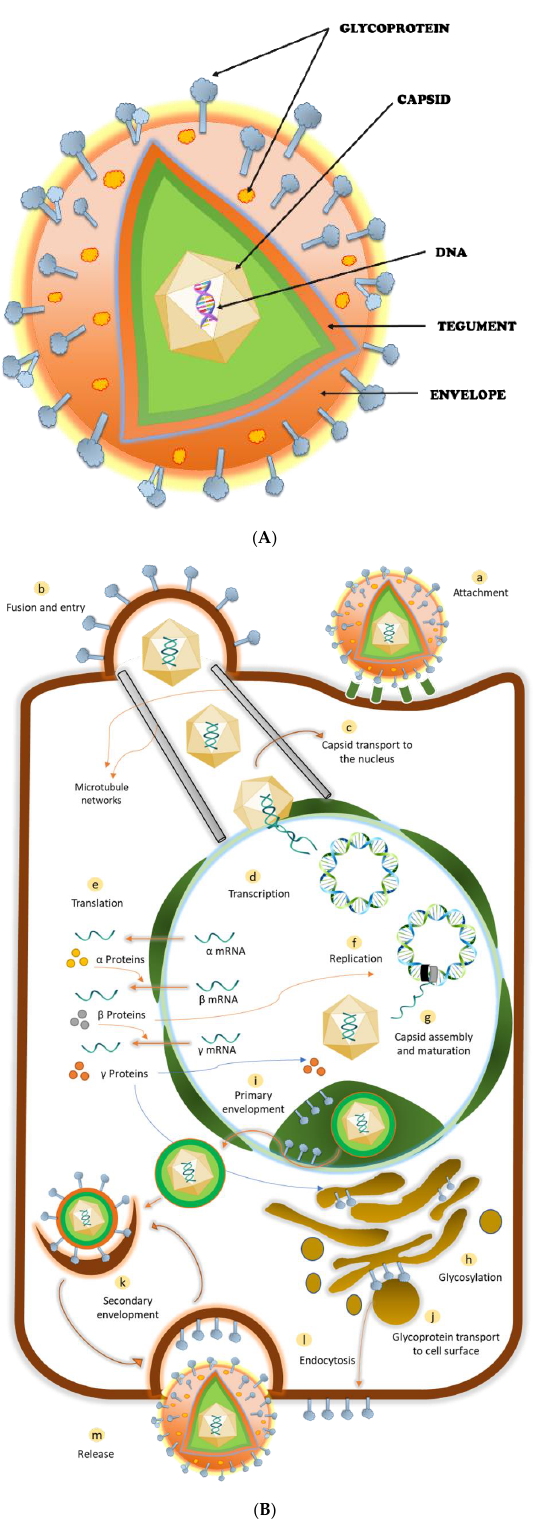
Figure 1. ( A ) Structure of herpes virus; ( B ) Life cycle of herpes virus.